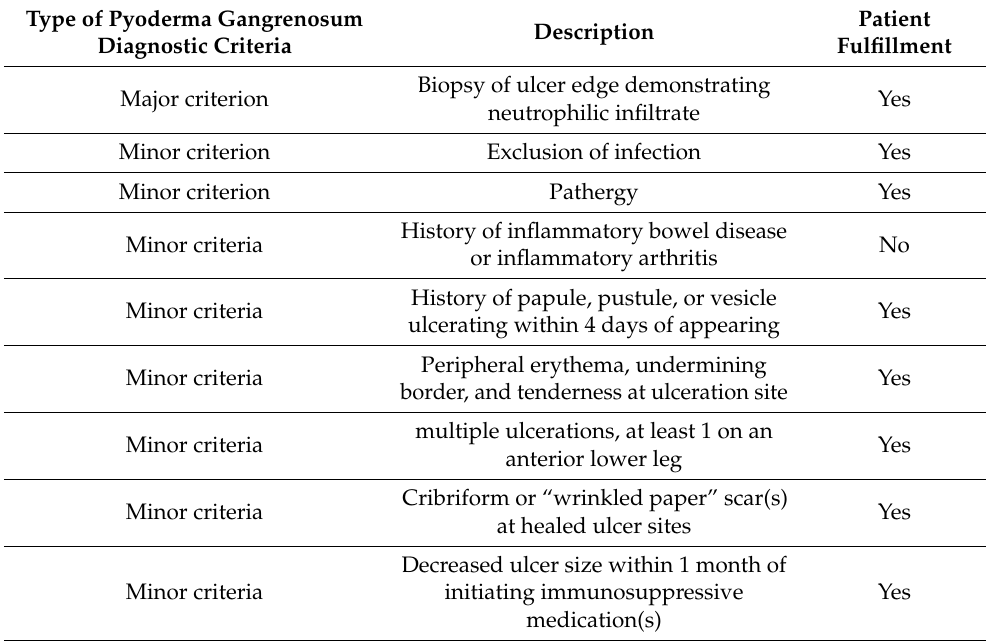
Patient Fulfillment